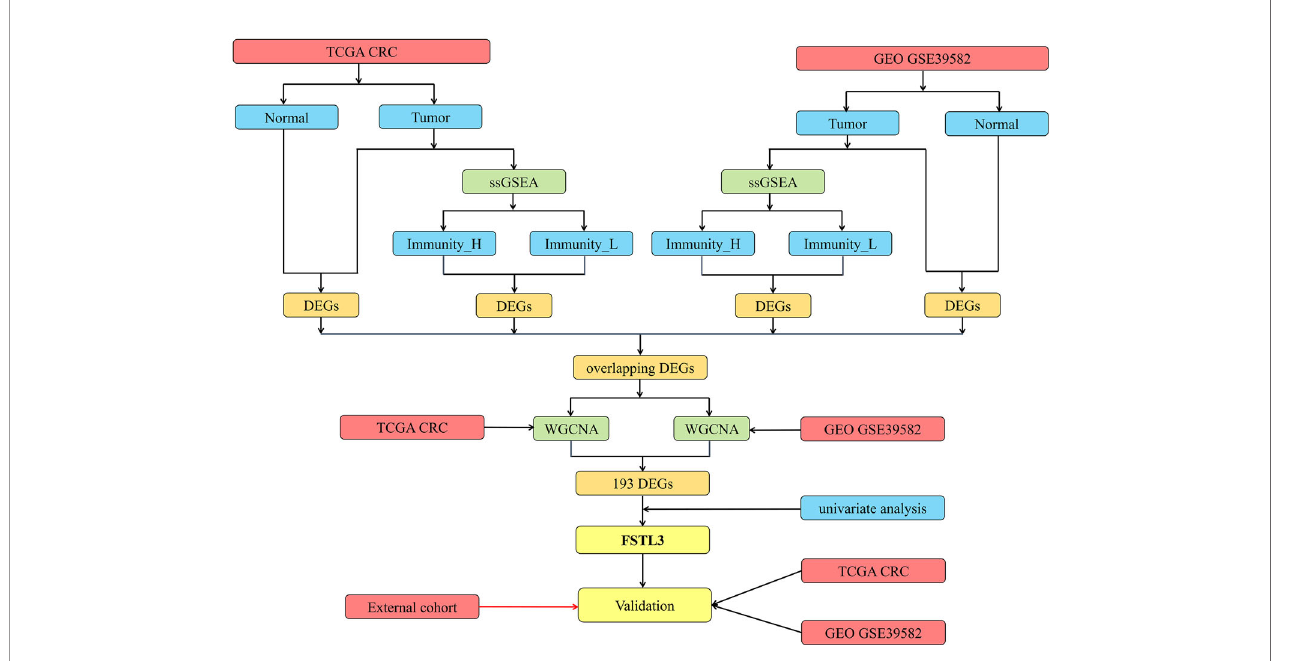
FIGURE 1 | Flow chart of the present